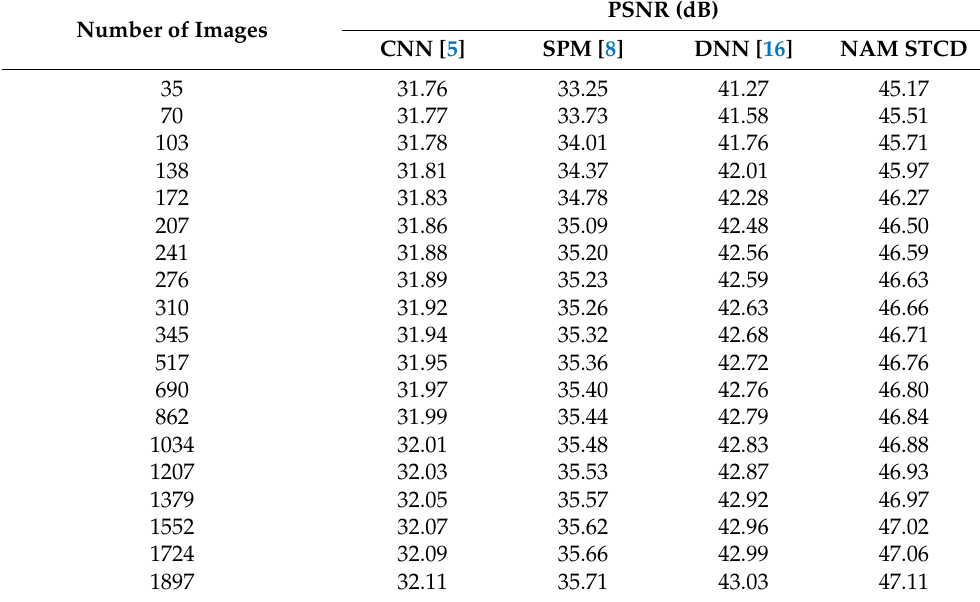
Table 3. PSNR of segmentation using different